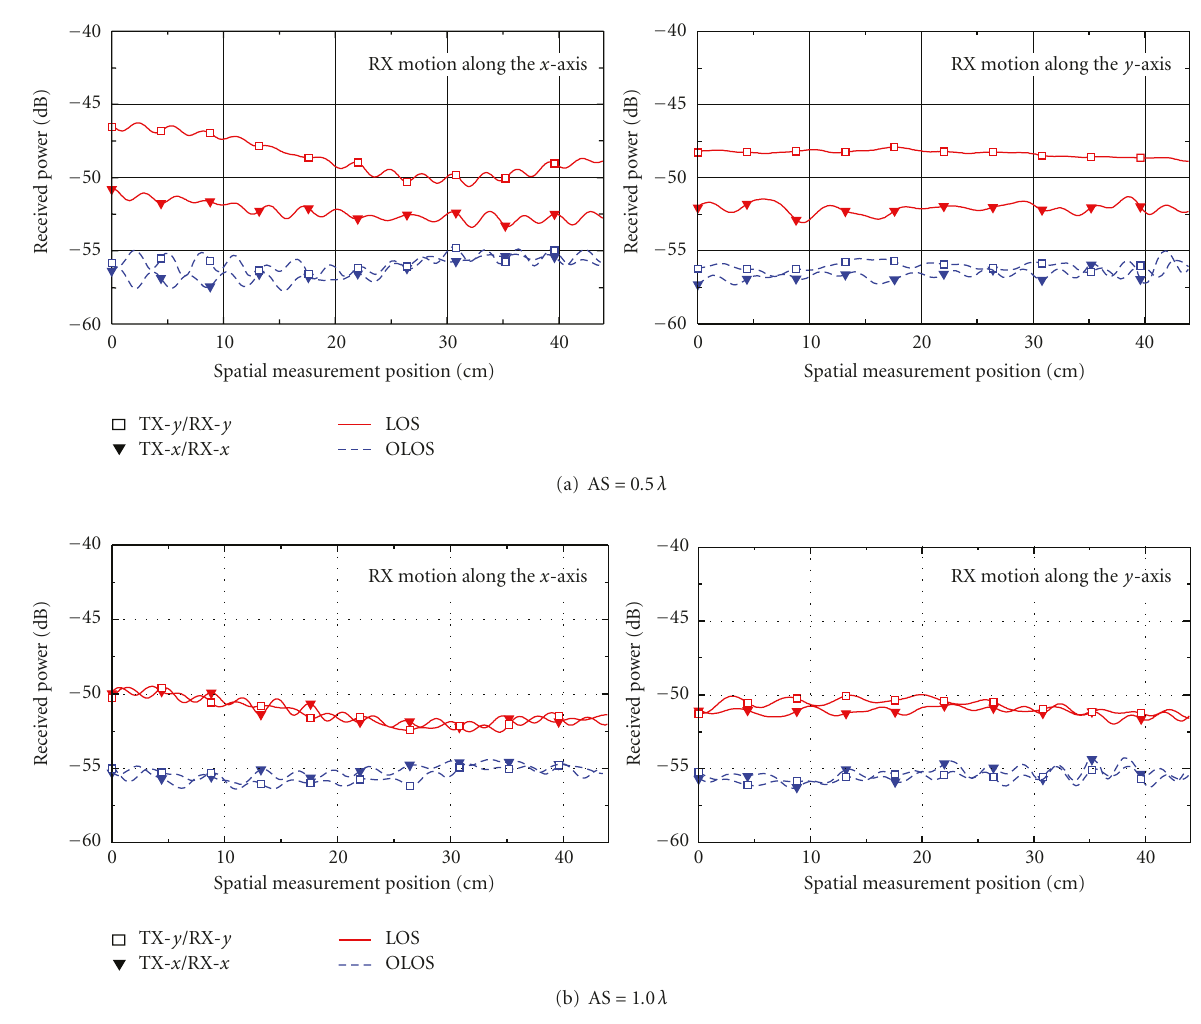
Figure 11: Received power of 2 × 2 MIMO channels averaged over the four channels and frequency domain data at each spatial measurement